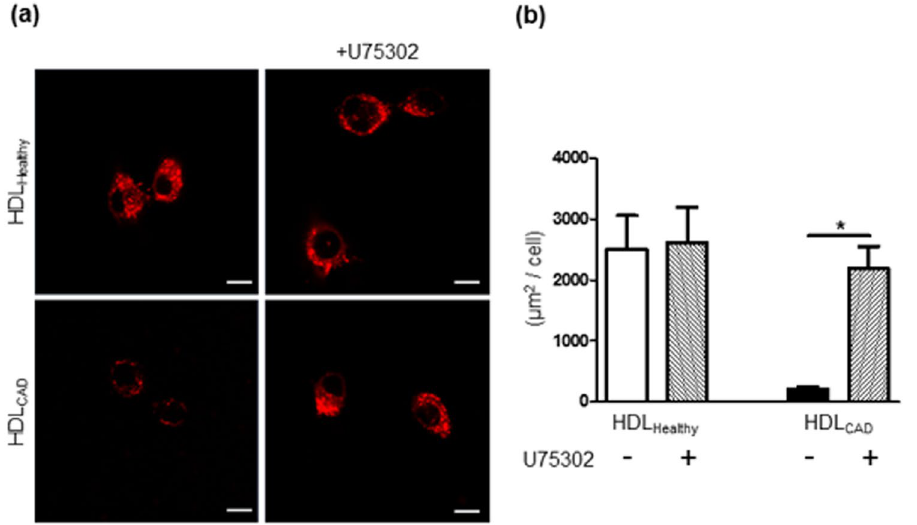
Figure 5. LTB 4 receptor antagonist promoted HDL CAD engulfment into macrophages. ( a ) Macrophages were pretreated for 30 min at 37 °C with or without LTB 4 receptor (BLT1) antagonist, U75302 (300 nM) and then were incubated with DiI-labelled HDL Healthy (upper panels) or DiI-labelled HDL CAD (lower panels) for 30 min at 37 °C. Scale bars = 10 μ m. ( b ) The DiI-positive area in macrophages ( μ m 2 /cell) was quantified by ImageJ. The data are shown as the mean ± SEM of 3 independent experiments. * P < 0.05.